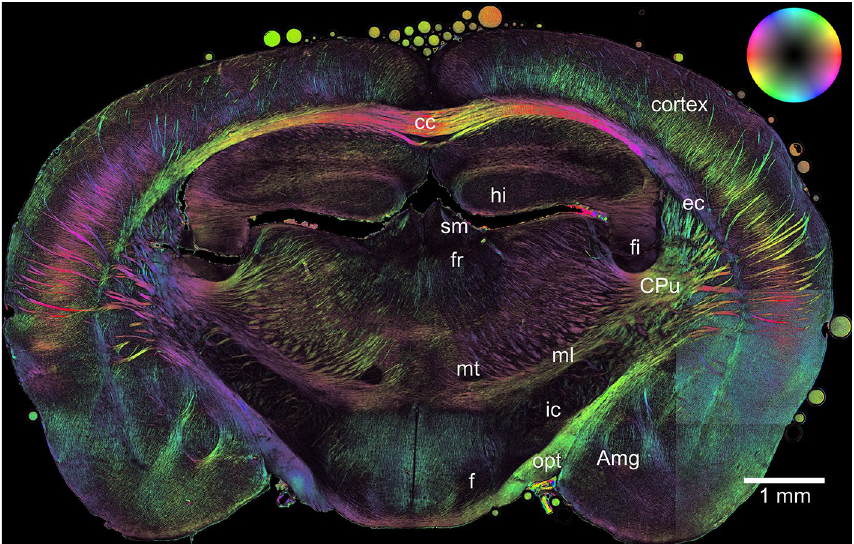
Figure 1. The 3D fiber orientation map (FOM) of a reeler mouse brain section. Anatomical parts of the section are labeled for reference; cc corpus callosum, hi hippocampus, sm stria medullaris, fr fasciculus retroflexus, fi fimbria hippocampi, CPu caudate putamen, mt mammilothalamic tract, ml medial lemniscus, ic internal capsule, opt optic tract, Amg amygdala, f fornix, ec external capsule. Color bubble: The color-coding corresponds to the orientation of the